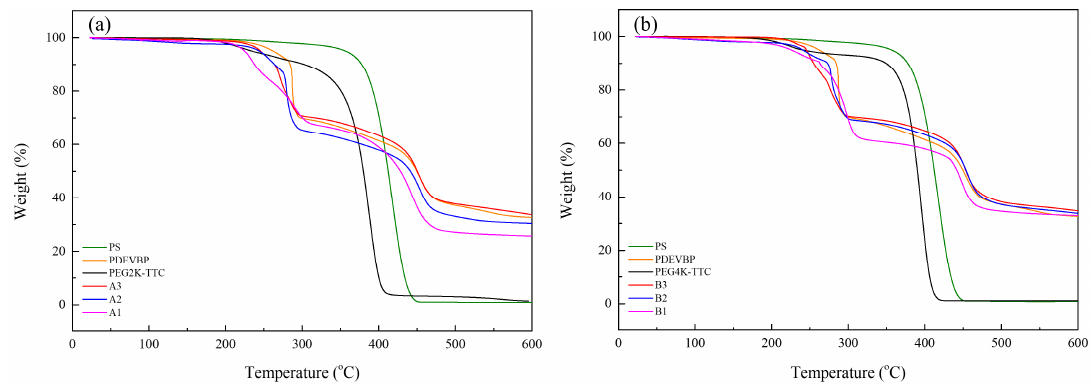
Figure 10. TGA measurements of ( a ) PEG2k-b-PDVBP, ( b ) PEG4k-b-PDVBP.